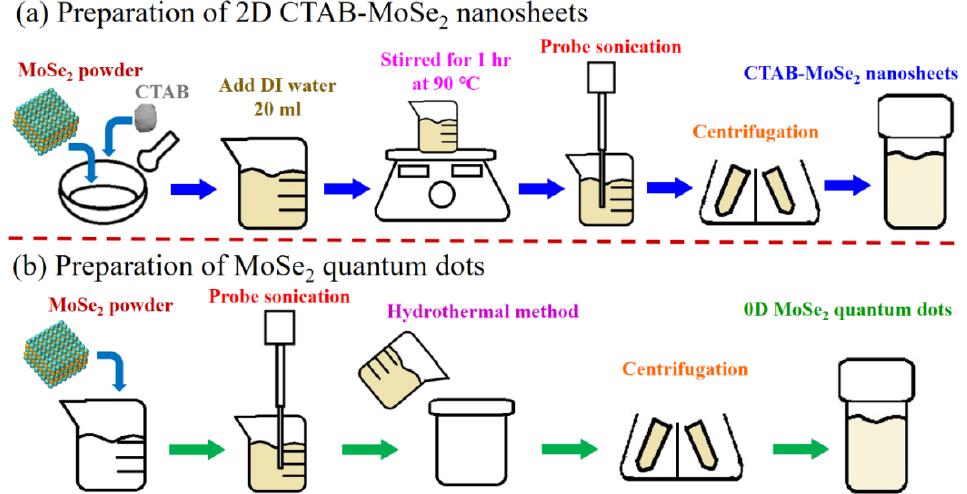
Figure 1. The schematic illustrations for the preparations of ( a ) two-dimensional (2D) cetyltrimethyl ammonium bromide (CTAB)-MoSe 2 nanosheets and ( b ) 0D MoSe 2 quantum dots (QDs).